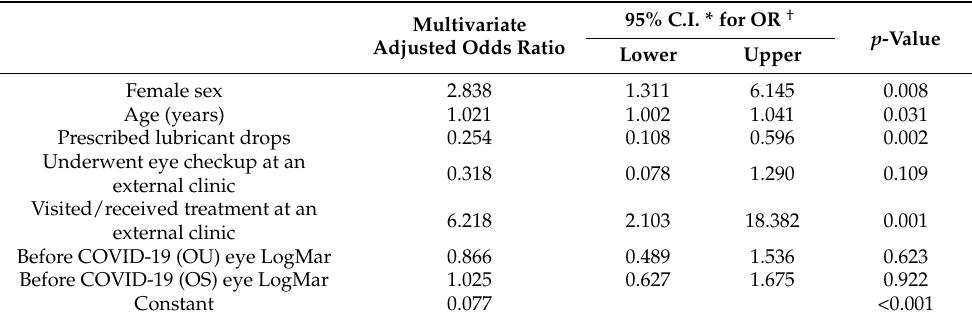
Table 3. Multivariate logistic binary regression analysis of the patients’ odds of experiencing wors- ened eye condition during pandemic time.